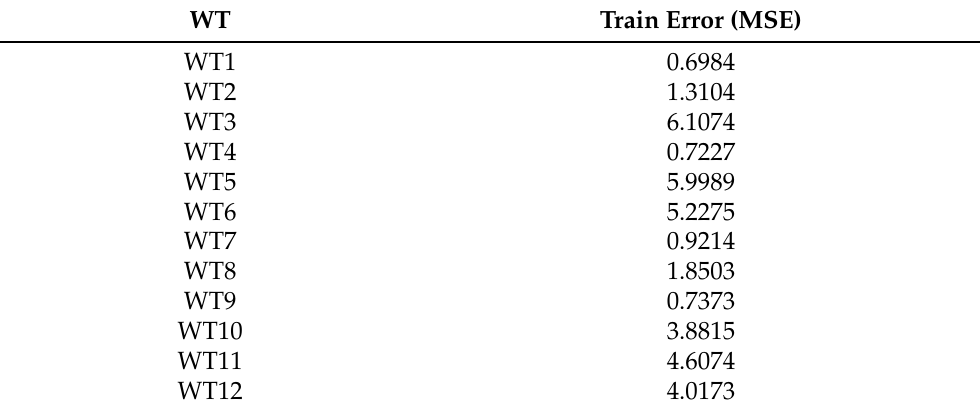
Table 8. Mean squared error (MSE) of the trained models for each WT. In all cases, the training time is close to 25 min ( ± 30 s) on a 3.2 GHz 6-Core Intel Core i7